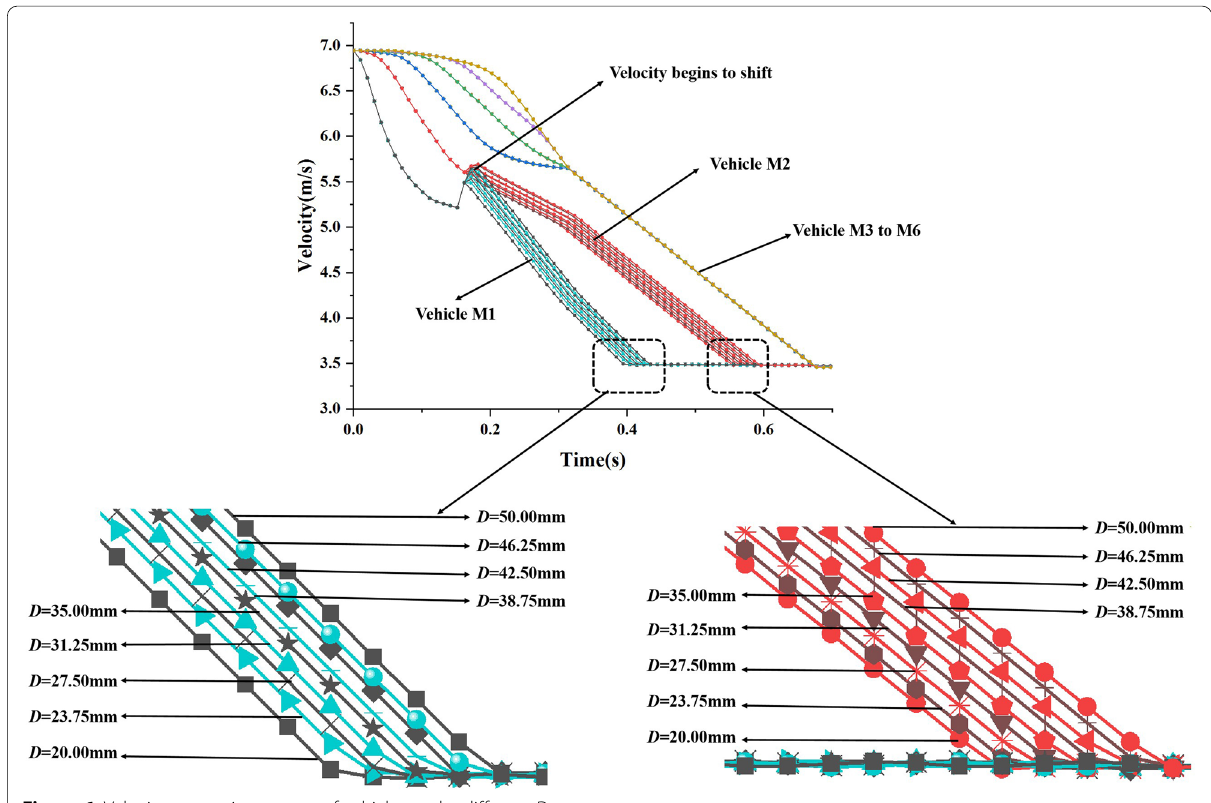
Figure 6 Velocity versus time curves of vehicles under different D